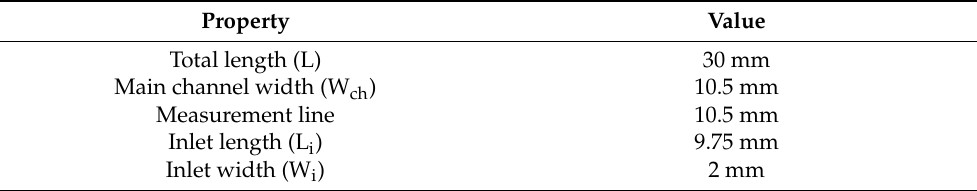
Table 1. Dimensions of the substrate.